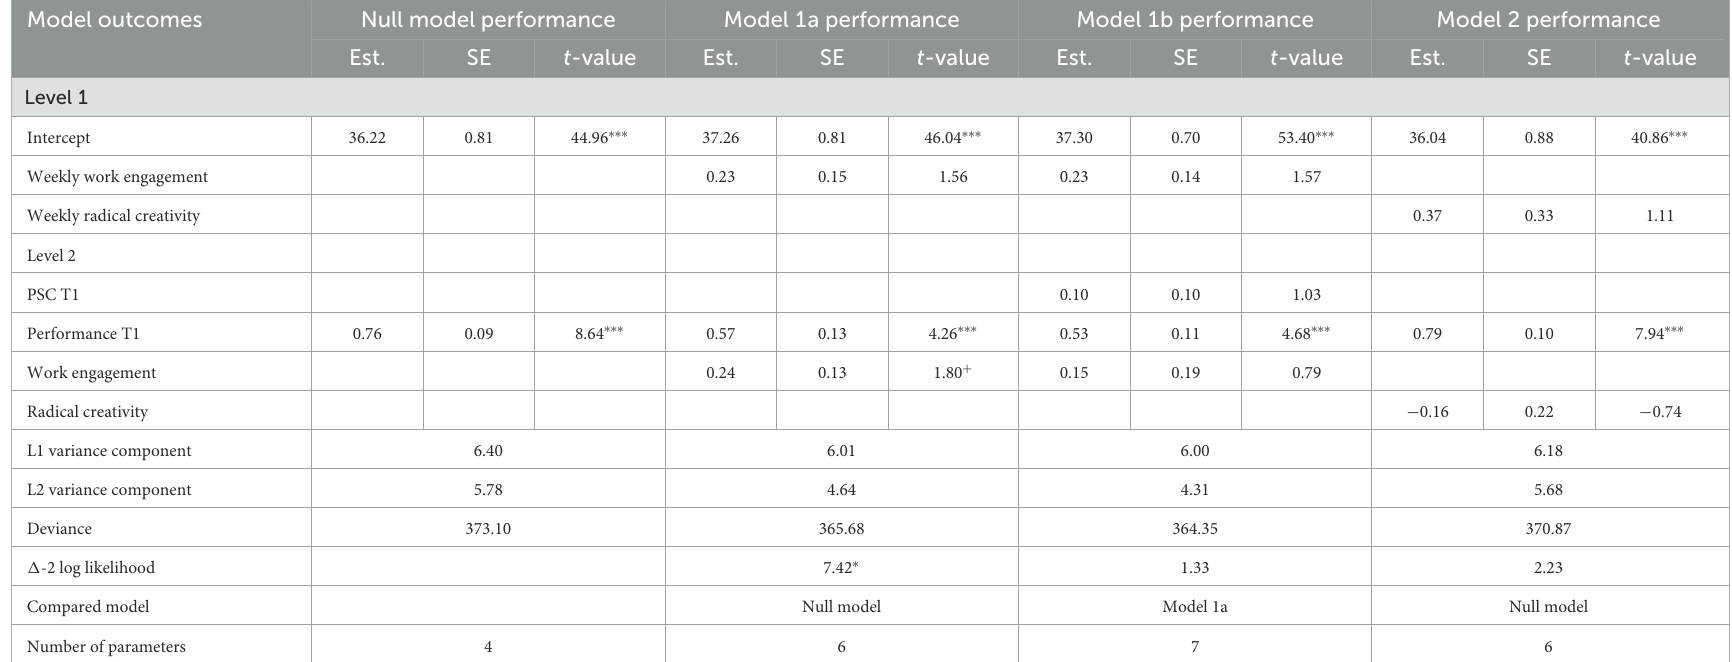
TABLE 3 HLM results of weekly performance as an